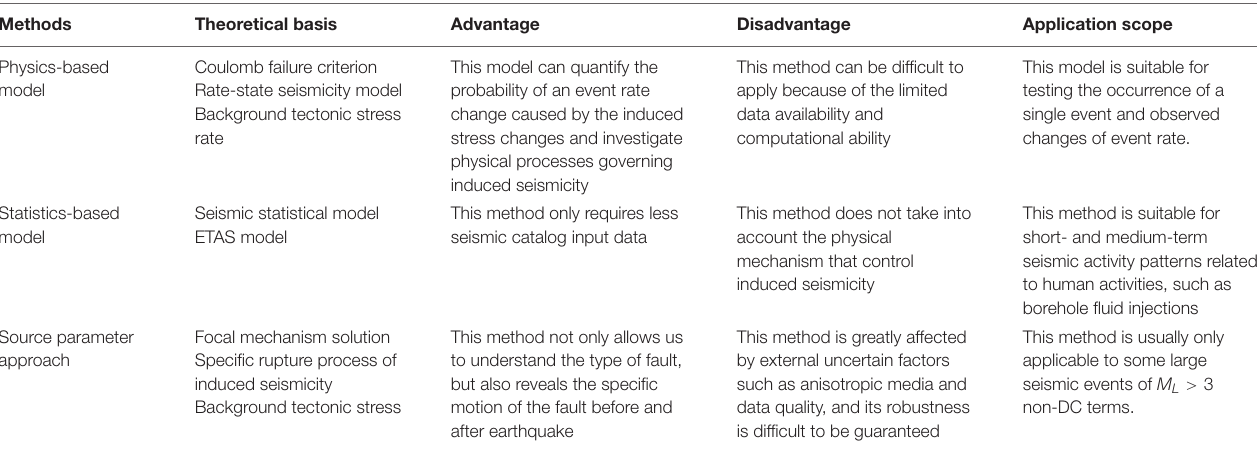
FIGURE 2 | Fault failure is induced by four possible mechanisms: (A) graviquakes, (B) reinjection quakes, (C) hydrofracturing quakes, (D) load quakes. The black solid Mohr circles represent the in-situ stress state of the fault before industrial production, while the blue dashed circles show the stress state after different changes. The red dotted lines mark the failure envelope in the safe state, and the red corresponds to the critical state. The fault is considered to fail when the Mohr circle is tangent to the envelope (as shown by the yellow star). [Modified from Doglioni (2018)] (This work is licensed under the CC BY-NC-ND license. http://creativecommons.org/licenses/by-nc-nd/4.0/). TABLE 1 | Basic information of three different discrimination